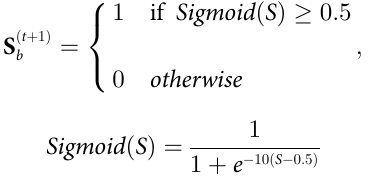
Algorithm 4 : The proposed binary bADGWDTO